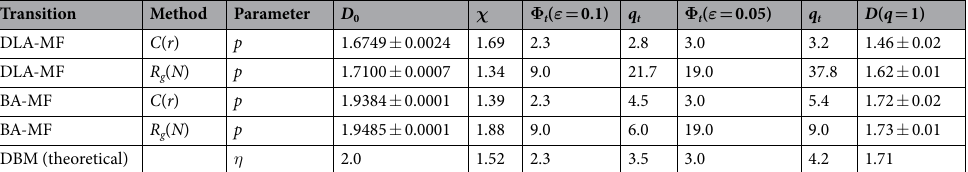
, where D 0 = 2. By fitting 0 0 (dashed black curve), while from i 0